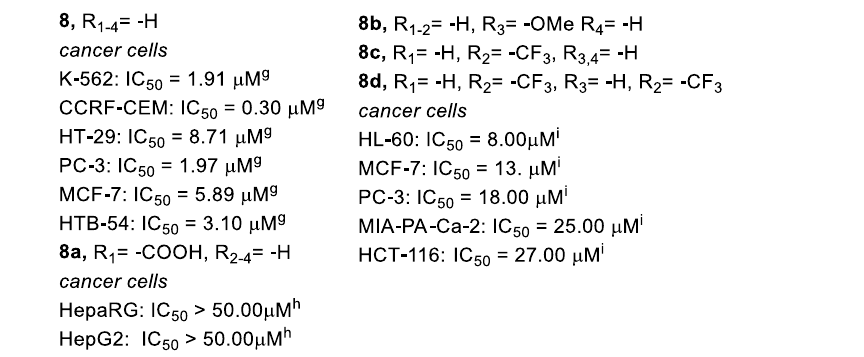
Figure 4. Chemical structures of representative inorganic and organic selenium compounds 1 - 8 dis- cussed in this review. Data from: a [55], b [56], c [57], d [58], e [39], f [59], g [60], h [61], i